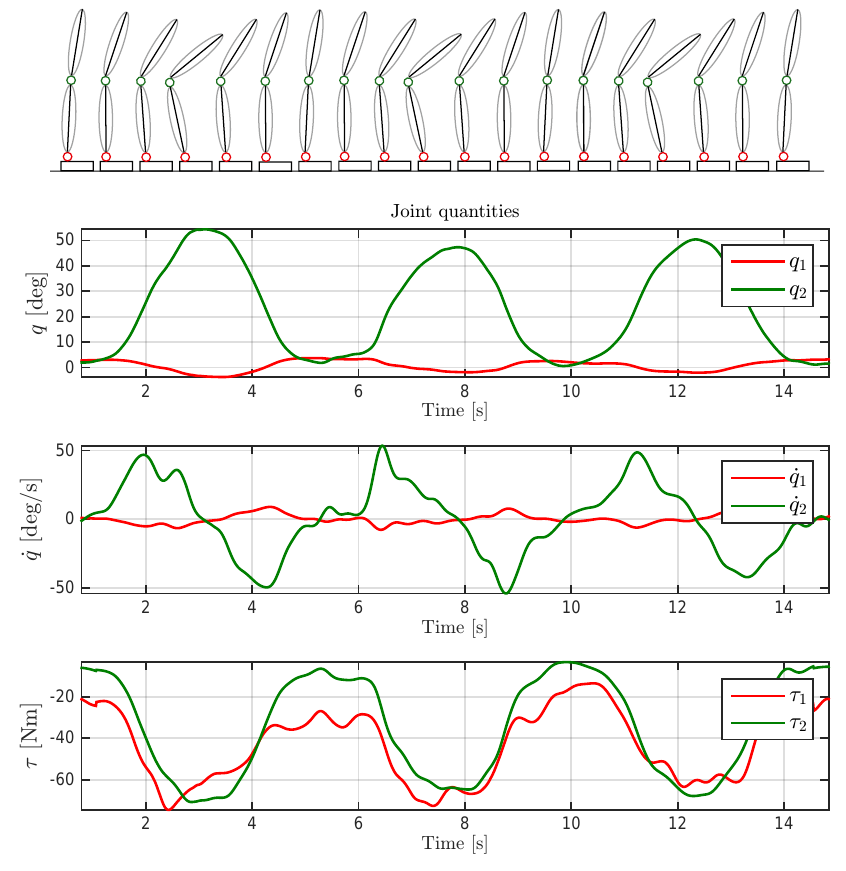
Figure 5. Representation of a trial composed of three repetitive bows ( on top ). Joint quantities: angles q 1 and q 2 have been obtained from motion capture acquisition with a frequency filtering; velocities ˙ q 1 and ˙ q 2 have been computed using a third-order polynomial Savitzky–Golay filtering; torques have been computed using MAP estimation exploiting all sensors involved in the analysis ( on bottom